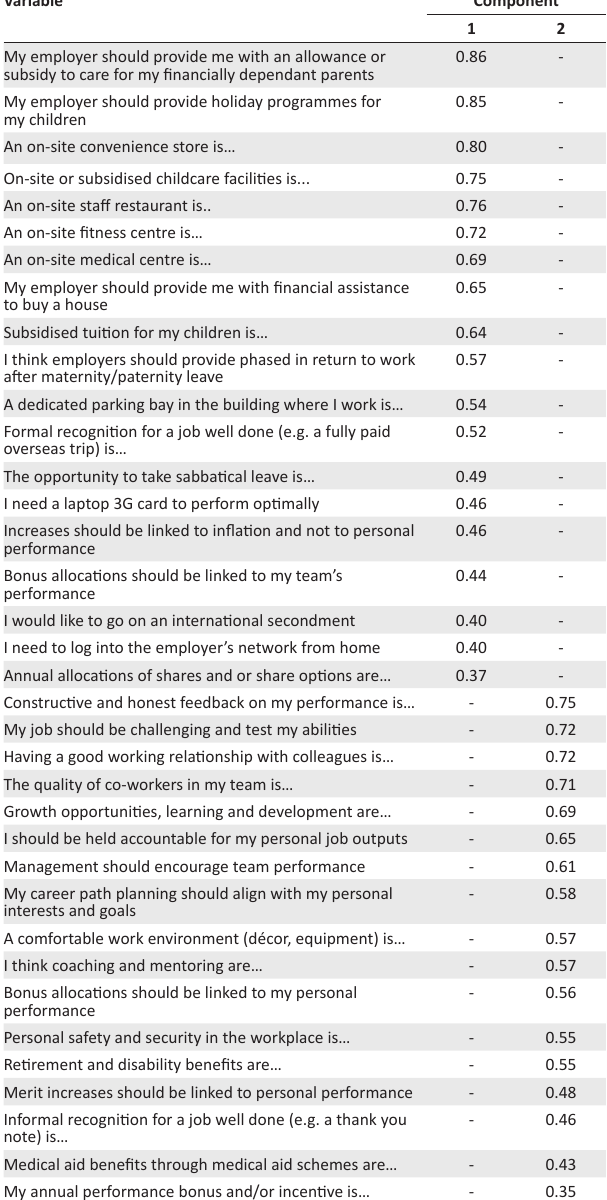
TABLE 3: Two-factor structure for total reward preference scale.